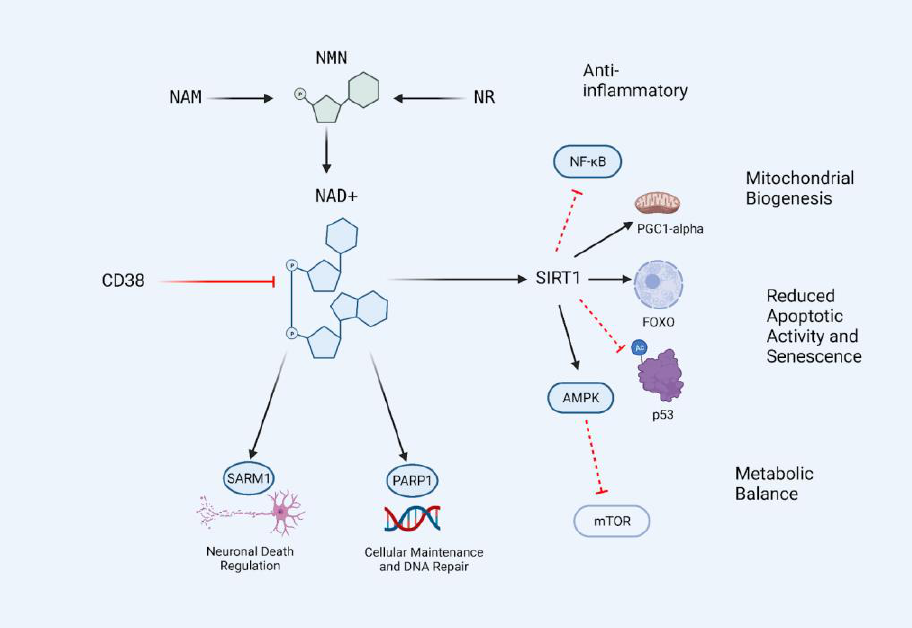
Figure 1. The CD38/NAD+/SIRT1 Axis. NAD+ levels in the body can be influenced by the supplementation of precursors nicotinamide (NAM), nicotinamide riboside (NR), and nicotinamide mononucleotide (NMN). NAD+ levels decrease with age and are further metabolized by the activation of SIRT1, PARP1, SARM1, and CD38. Restoring NAD+ levels allows for an increase in SIRT1 activity due to increased substrate availability, resulting in the inhibition of age-promoting pathways and activation of adaptive and protective transcription factors and processes. The central lineage may be described as the CD38/NAD+/SIRT1 axis, and targeting this access with nutraceutical interventions may prevent the age-related decline of NAD+ levels in the body. Black lines indicate conversion or activation. Red lines indicate inhibitors or destroyers of the indicated target.